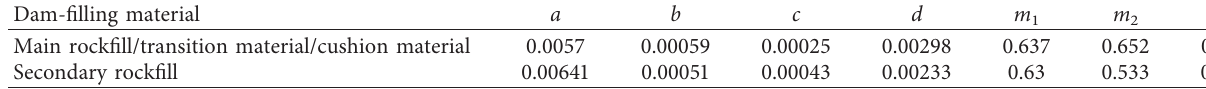
Table 6: Creep model parameters of the rockfill.